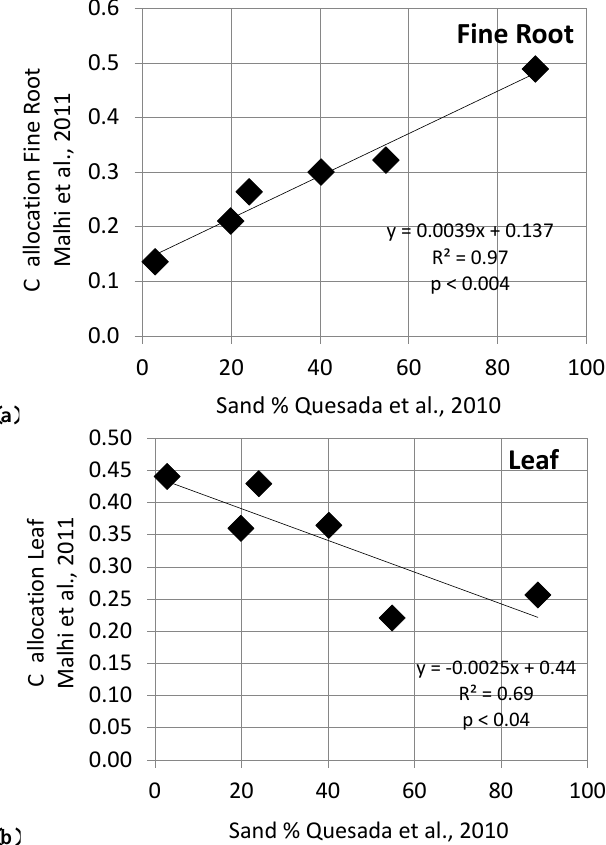
Fig. 2. The relationship between fraction of NPP allocation to fine roots and percentage of sand in soil (a) , same for carbon allocation to leaves and percentage of sand in soil (b) (Malhi et al., 2011; Quesada et al.,